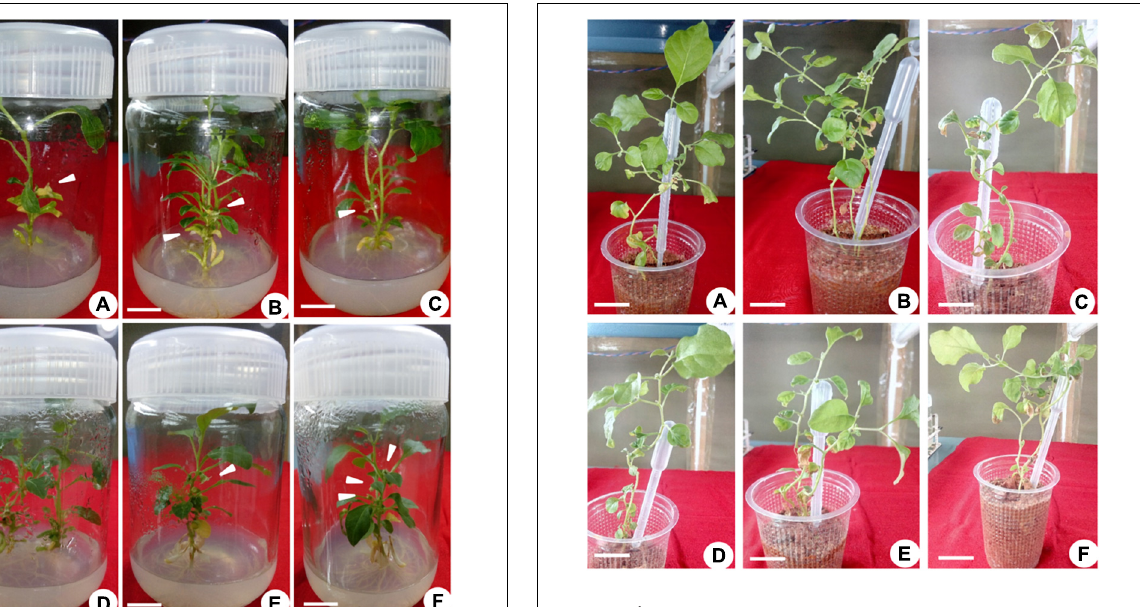
FIGURE 4 | Ex vitro flowering in 30-day-old plantlets of Withania somnifera . Flower formation from (A) 6th node (scale bar = 13.7 cm), (B) 7th node (scale bar = 14.4 cm), (C) 11th node (scale bar = 17.5 cm), (D) 10th node (scale bar = 12.8 cm), (E) 10th node (scale bar = 12.5 cm), and (F) 12th node (scale bar = 17.6 cm).